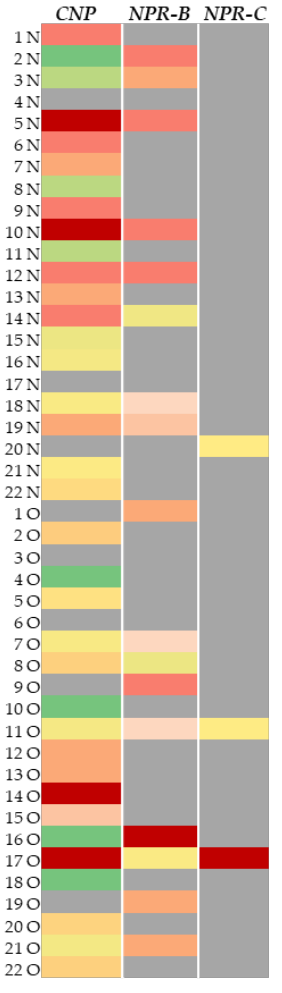
Figure 2. Heat-map representation of mRNA expression levels of CNP, NPR-B , and NPR-C . Dark red: higher expression levels (≥ 33 cycles), green: lower ones (> 38.5 cycles), grey: No expression. Median levels of expression were represented in light red, light green, orange and yellow (35.5 < X < 38 cycles) (N = Normal-weigh subjects; O = Obese subjects).